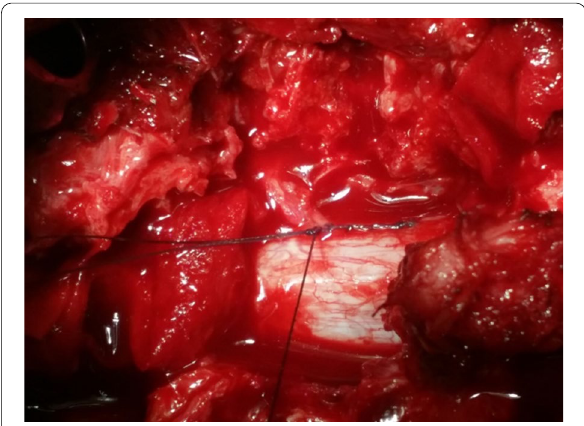
Fig. 2 Intra-operative photo of thecal sac showing complete simple closure of incidental dural tear using 5–0 silk